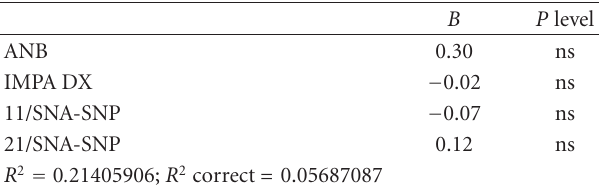
Table 5: Group 1 (25 subjects): linear regression results OJ-r; no independent variable was found to be statistically significant in the multivariate linear regression model. The systematic error calculated via Student’s t -test for paired data yielded a significance level of 0.05; ns: non significant (Student’s t -test). B P level